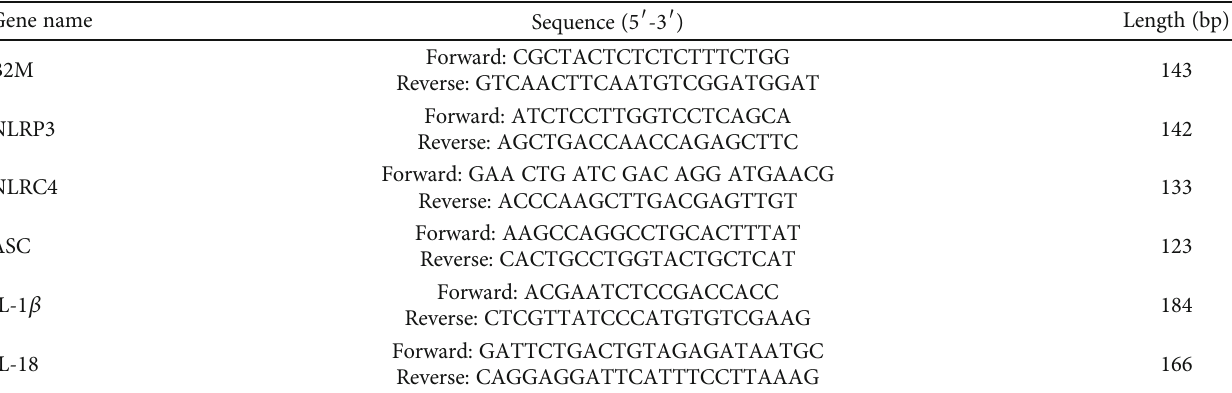
Figure 1: Schematic presentation of the experimental protocol. The cells in blank group were treated only with ATP (5 mM, 30 min). The cells in LPS control group were treated with LPS (10 μ g/ml, 6 h) and ATP (5 mM, 30 min). In RT group, the cells that had been treated with 10 μ M AEA for 24 h induced with LPS (10 μ g/ml, 6 h), and in OT group, the cells were treated with AEA (10 μ M, 24 h) after treatment with LPS (10 μ g/ml, 6 h), and the last two groups were treated with ATP (5 mM, 30 min) after LPS induction. Table 1: Characteristics of primer sequences used in the present